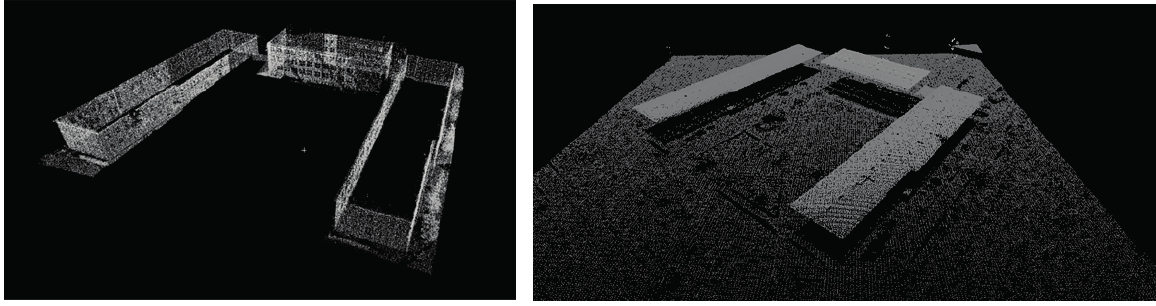
Figure 9. TLS data set (on the left); ALS data set (on the right).